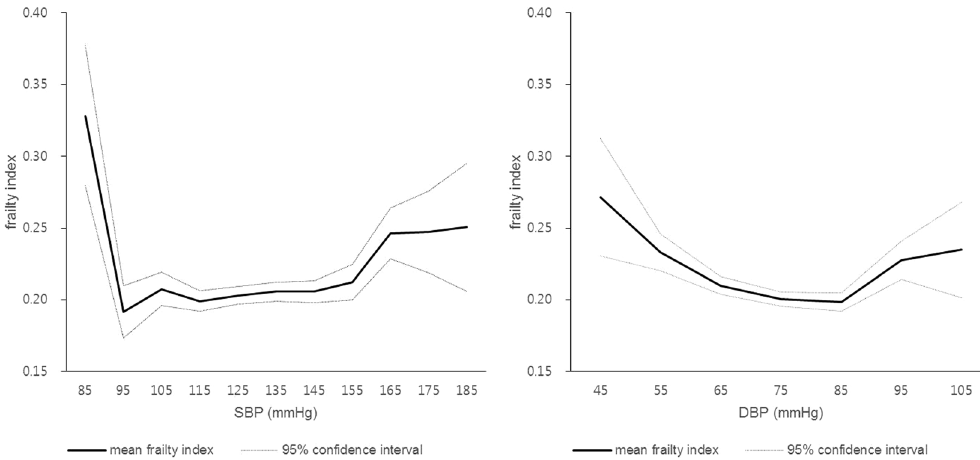
Figure 3. Frailty index (mean) in Korean elderly according to SBP and DBP. SBP: systolic blood pressure, DBP: diastolic blood pressure. U-shape relationship between frailty index and blood pressure was